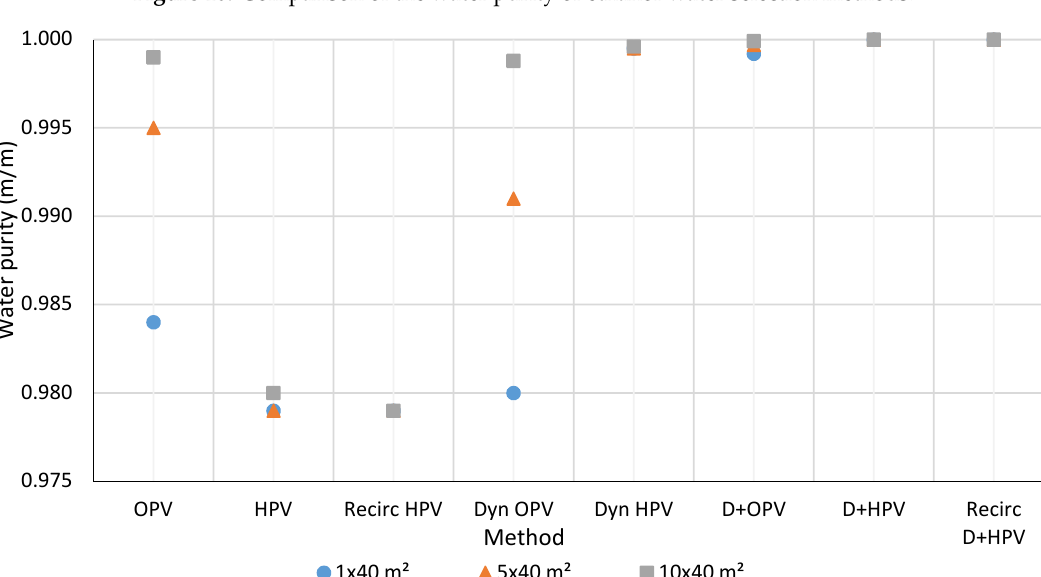
Figure 11. Comparison of the water purity of methanol-water separation methods.